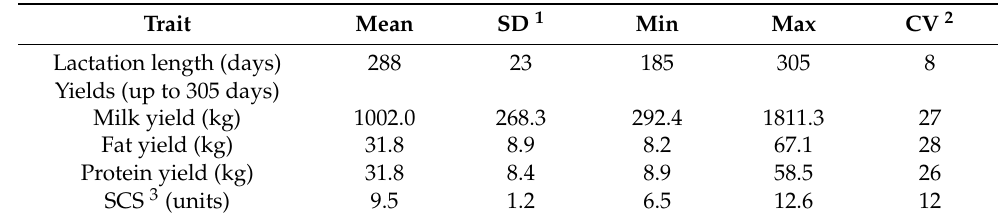
Table 2. Descriptive statistics of milking traits of 839 dairy goats kidding in the 2016 season from a single New Zealand herd.